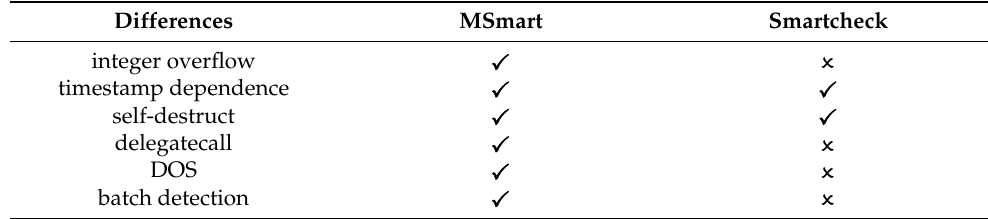
Figure 9. uint256 (cnt) * _value code analysis tree. Table 1. Differences between MSmart and Smartcheck.